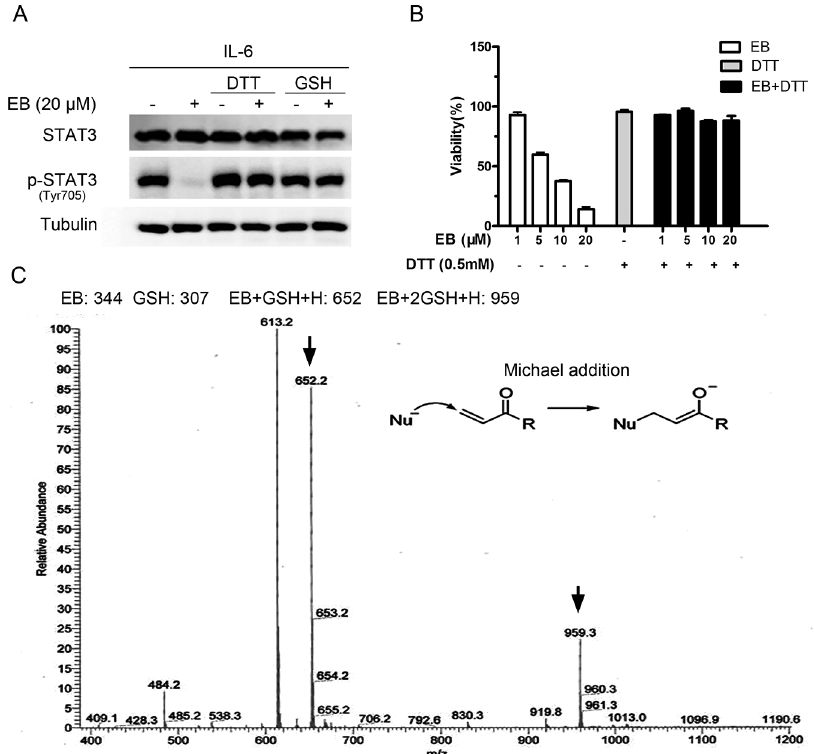
Fig 4. DTT and GSH abolished the EB-caused JAK-STAT3 inhibition. (A) A549 cells were pretreated with DTT (0.5 mM), GSH (2 mM), EB (20 μ M) or their mixture (EB and DTT/GSH were pre-incubated at RT for 30 min) for 2 h and then stimulated with IL-6 for 15 min. Whole cell lysates were processed for western blot analysis using antibodies as indicated. (B) A549 cells were cultured in the presence of indicated concentrations of EB or EB + DTT (0.5 mM) for 48 h and then the viability of A549 cells was analyzed by MTT assay. (C) EB (50 μ M) was incubated with GSH (250 μ M) at 37°C for 2 h, and the products were resolved by mass spectrometry. A possible Michael addition reaction between EB and GSH is illustrated. The black arrows indicated the molecular weights of EB+GSH and